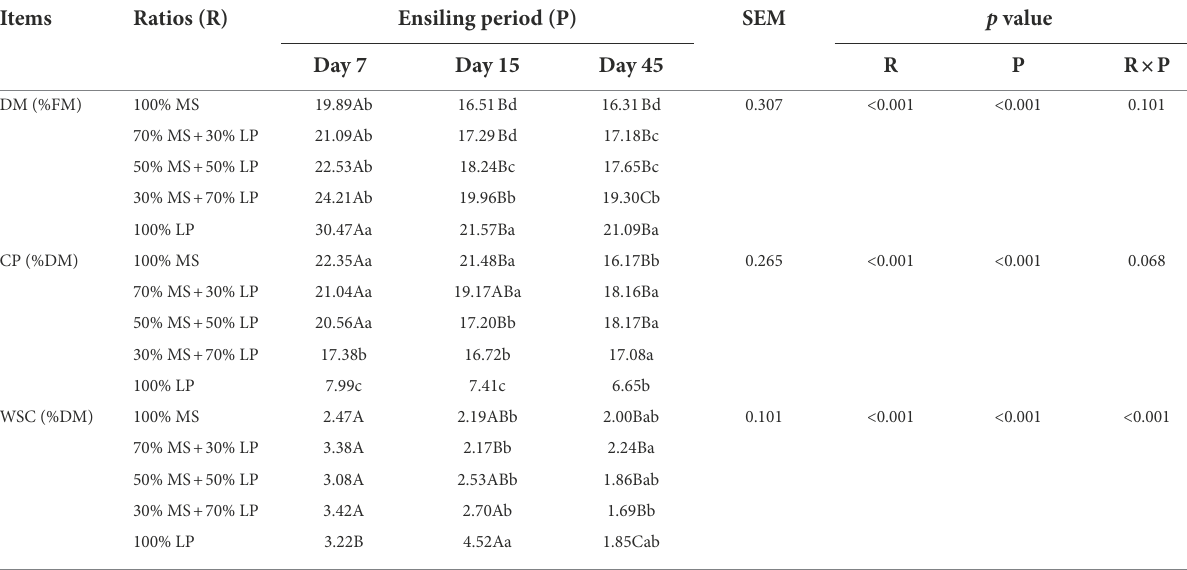
TABLE 2 Dynamic changes in nutrients in mixed silage of perennial ryegrass and alfalfa.